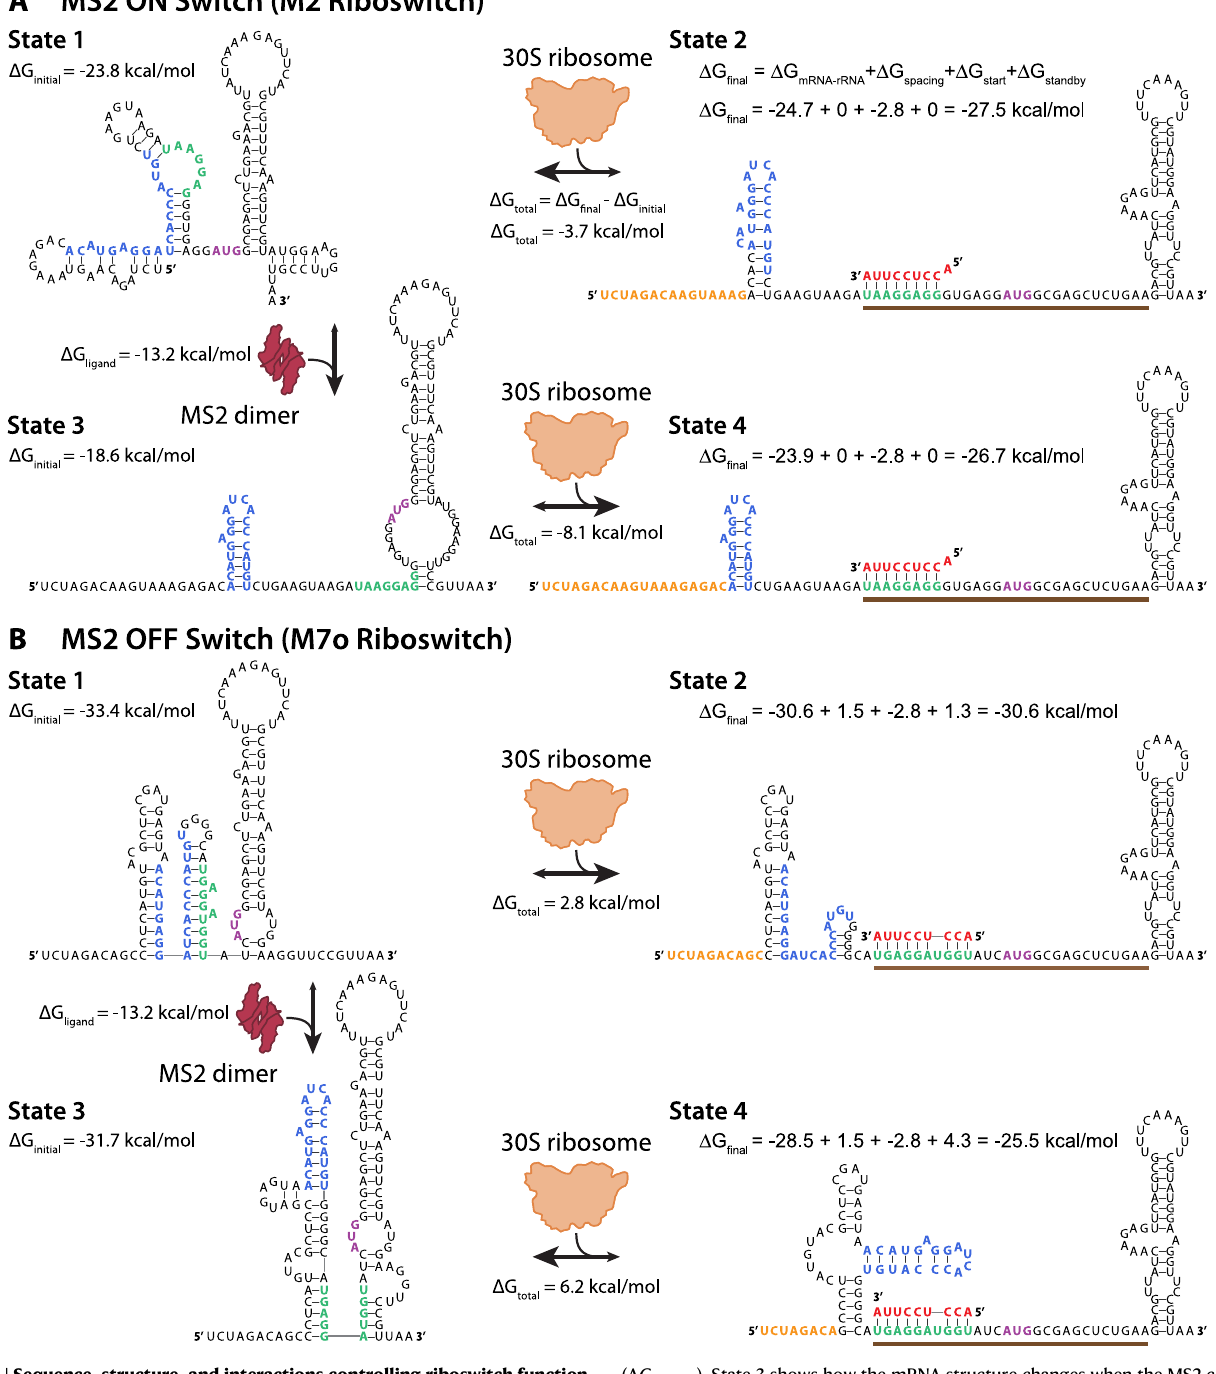
( Δ G standby ). State 3 shows how the mRNA structure changes when the MS2 coat protein binds to its cognate RNA aptamer with binding free energy Δ G ligand , which resultsinachangeinmRNAfoldingfreeenergy( Δ G initial ).State4showsthechange inmRNAstructureand fi nalGibbsfreeenergy( Δ G fi nal )whentheribosomebindsto the mRNA in State 3. The translation initiation rates are predicted based on the differenceininitialand fi nal Gibbs free energies ( Δ G total ) according toBoltzmann ’ s relationship. Nucleotides are colored according to their interactions, including (blue) the RNA aptamer domain, (red) the last 9 nucleotides of the 16S ribosomal RNA, (green) the Shine – Dalgarno sequence, (purple) the start codon, and (orange) the standby site. The brown bar is the ribosomal footprint for